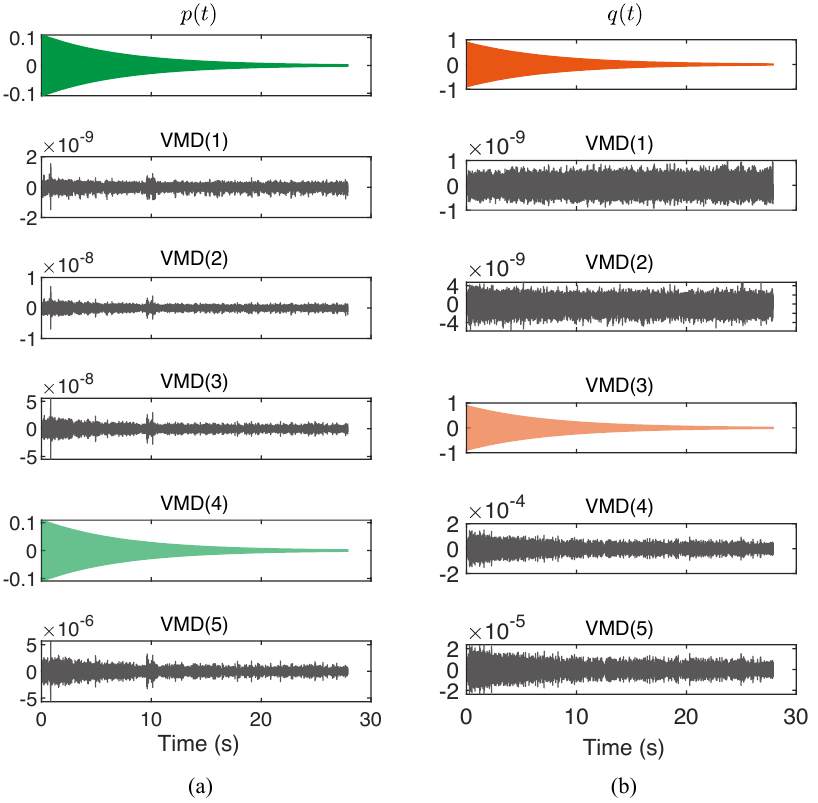
Figure 17. The variational mode decomposition of the modal vibrations ( a ) p ( t ) and ( b ) q ( t )